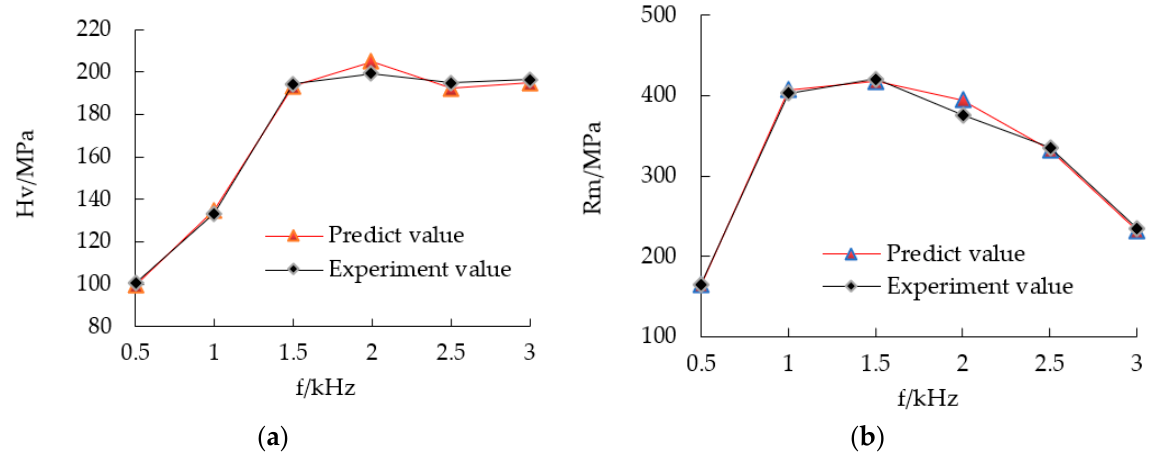
Figure 5. Comparison between the experimental and predicted values with different frequencies. ( a ) Microhardness and ( b ) tensile strength.